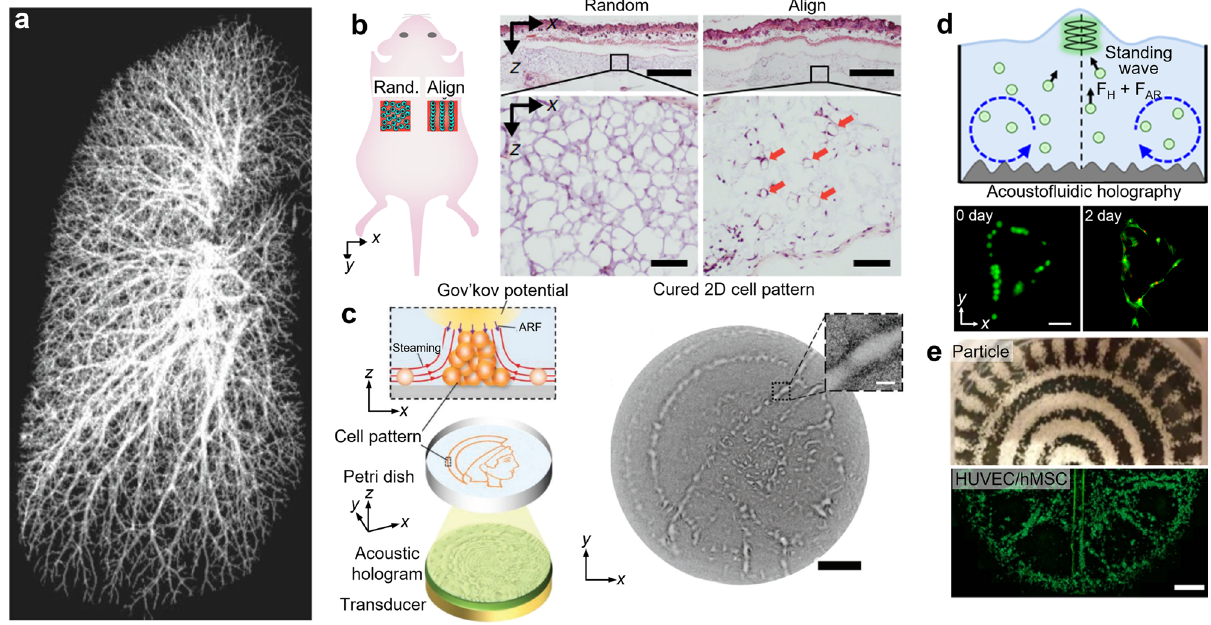
Fig. 4 Acoustic technologies for tissue engineering. a Computed tomographic (CT) images showing the complexity of the arteries and veins found within human lungs. Recreating these intricate vascular trees remains a challenge for state-of-the-art tissue engineering techniques. b Acoustic waves were used to align human stem cells and endothelial cells into precise lines within a hydrogel. When transplanted into ischemic muscle in a mouse model of hindlimb ischemia, the acoustically aligned stem cells and endothelial cells exhibited an increased density of microvessels and enhanced paracrine effects as compared to randomly distributed cells. Scale bars: 500 μ m (upper image) and 200 μ m (lower image). c Acoustic holography represents one approach for fabricating complex, arbitrary patterns of cells in hydrogels, which then undergo gelation to immobilize the patterns. Scale bar: 5 mm. Scale bar (inset): 500 µ m. d An acousto fl uidic holography approach that also utilizes the induced fl uid motion to pattern cells in hydrogels with higher spatial resolution. Scale bar: 50 µ m. e An alternative acoustic approach known as sound-induced morphogenesis (SIM) can be used to rapidly pattern particles (top) and cells (bottom) in hydrogels. Here, the patterns formed are a function of the acoustic parameters and chamber geometry. Scale bar: 500 µ m. Part a adapted